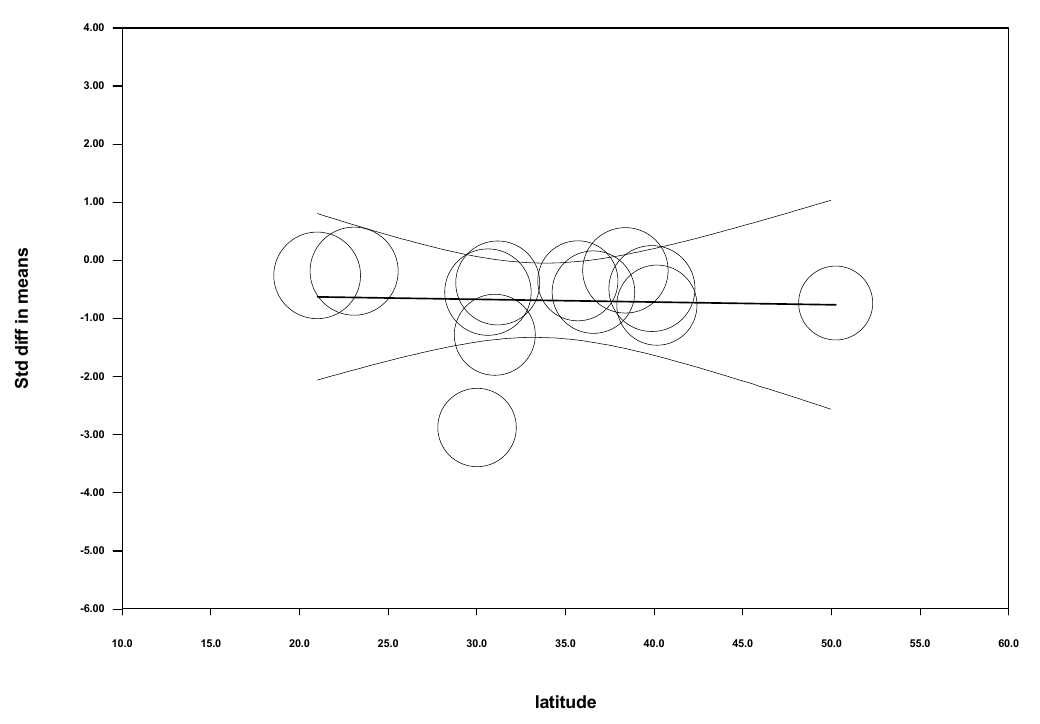
Figure 6. Cases vs. Controls: Scatterplot for latitude.